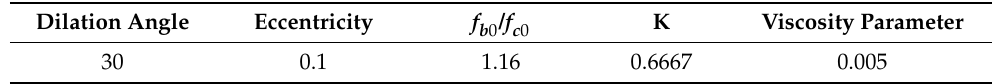
Figure 13. Stress–strain curve of the steel bar.